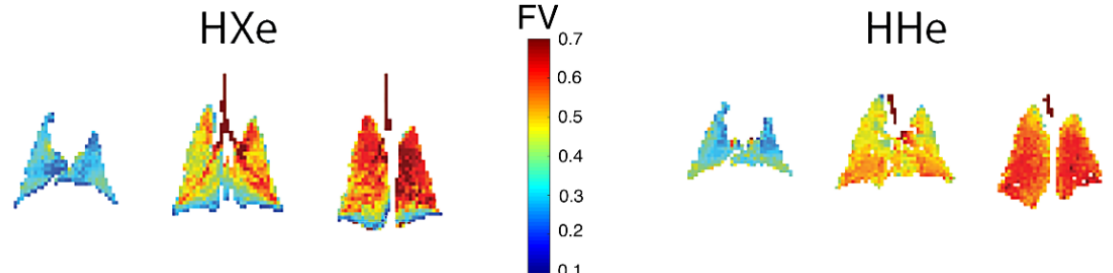
Figure 6. Ventilation inhomogeneity related to posture/gravity and the transition between flow- and diffusion-dominant transport in small airways are known to be present in all species. Gravitationally lower regions experience more efficient gas exchange as in the rabbit model above, and the denser 129 Xe gas ( left , HXe) additionally experiences a central-to-peripheral and apical to basal gradient when compared the lighter 3 He ( right , HHe). Each set of three images depicts slices from anterior (left) to posterior (right).